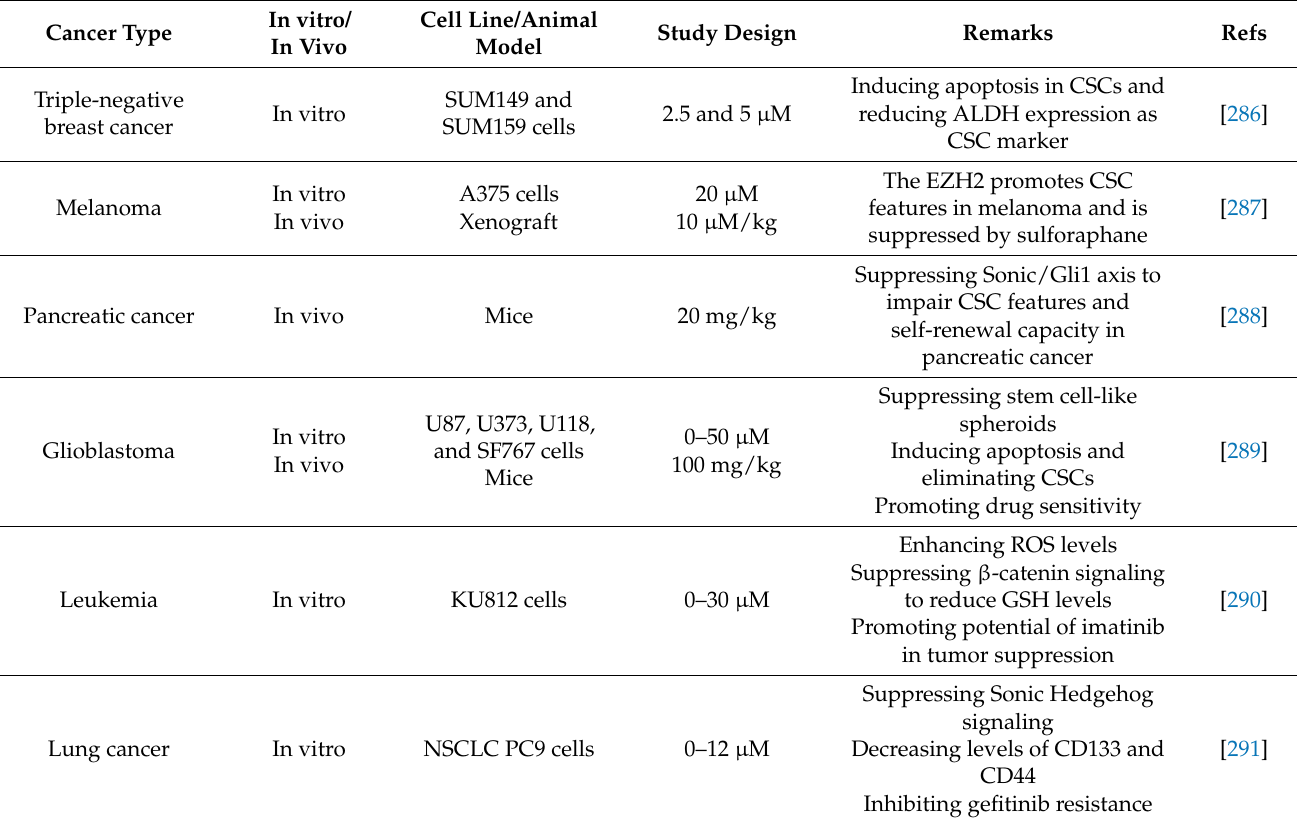
Figure 4. The potential of carotenoids in suppressing CSCs. Table 5. The sulforaphane as a potential anti-tumor agent in cancer therapy.